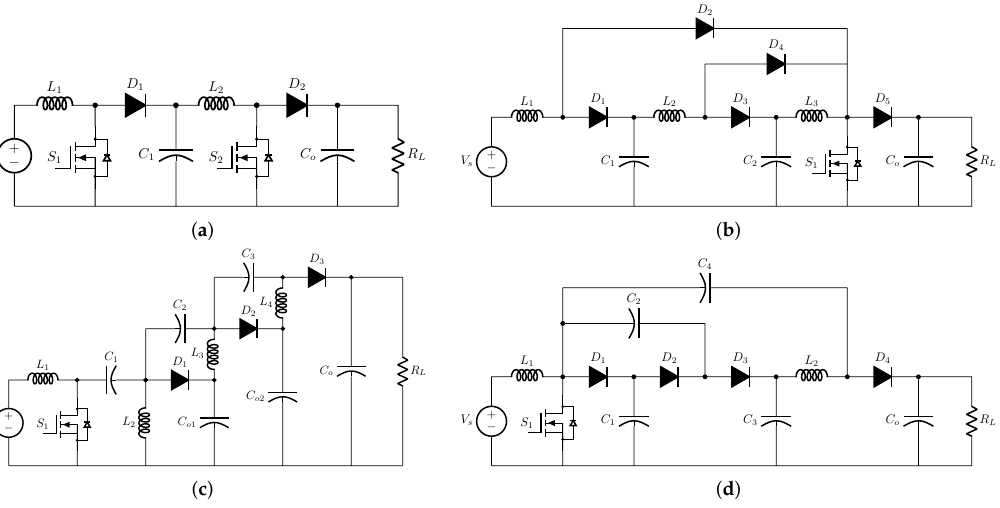
Figure 3. Cascaded Topologies for Symmetric and Non-symmetric Converters. ( a ) Double Boost Converter (DBC), ( b ) N-Stage Boost Converter, ( c ) SEPIC based on Buck-Boost Converter and ( d ) Double Boost SEPIC